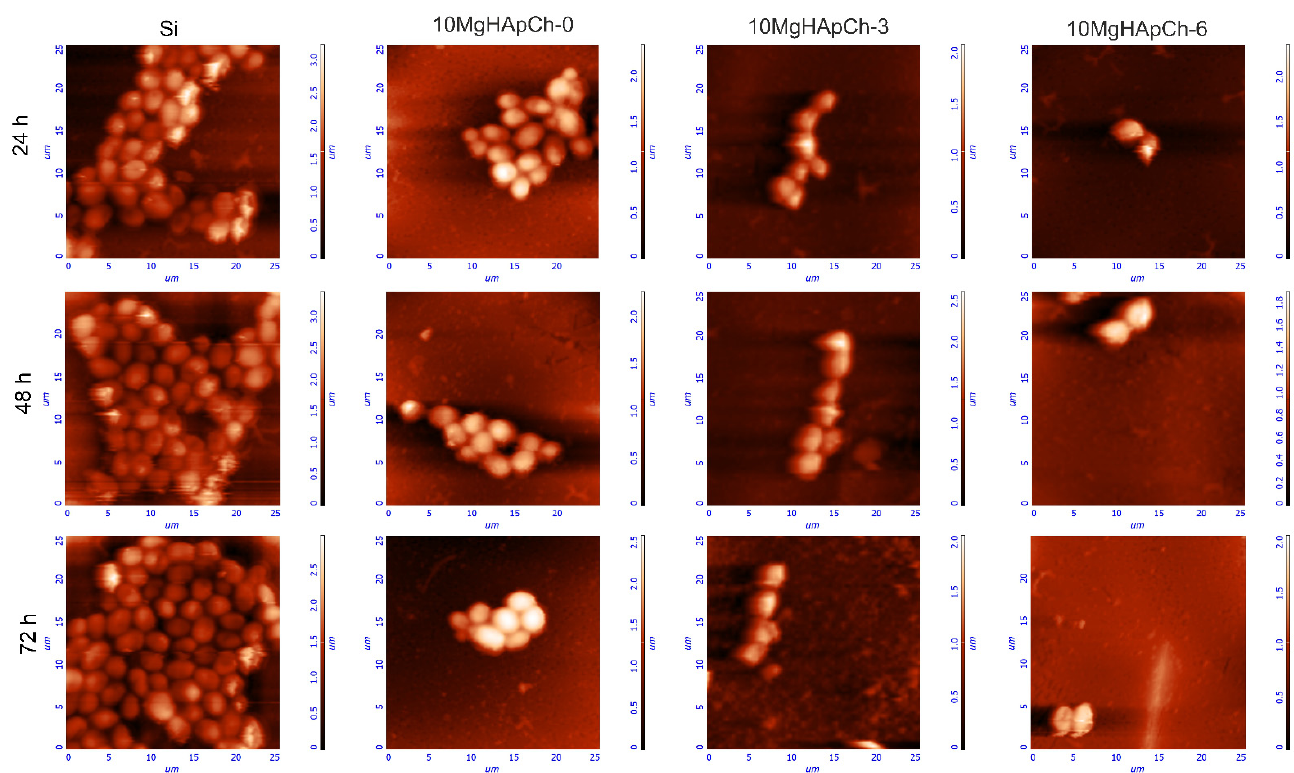
Figure 14. 2D AFM surface topography of Candida albicans ATCC 10231 cell development on Si discs, 10 MgHApCh-0, 10 MgHAp-Ch-3, and 10 MgHAp-Ch-6 composite layers after 24 h, 48 h, and 72 h of incubation collected on an area of 25 × 25 µm 2 .